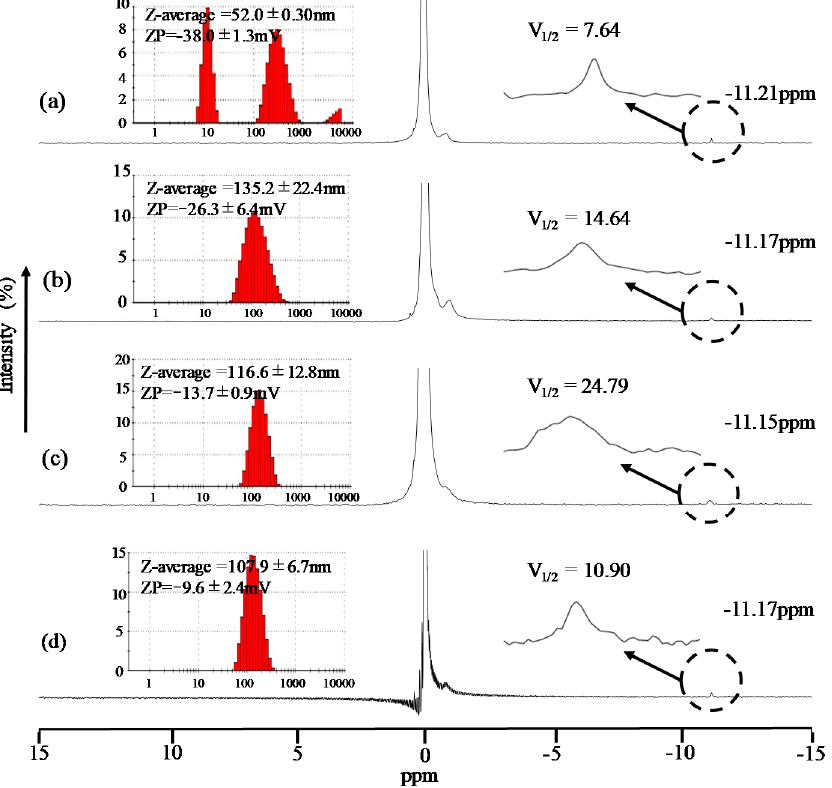
Figure 7. 31 P-NMR spectra of DSPE-PEG 2000 and Soluplus, ( a ) DSPE-PEG2000, ( b ) DSPE- PEG2000/Soluplus = 2/1, ( c ) DSPE-PEG2000/Soluplus = 1/1, ( d ) DSPE-PEG2000/Soluplus =